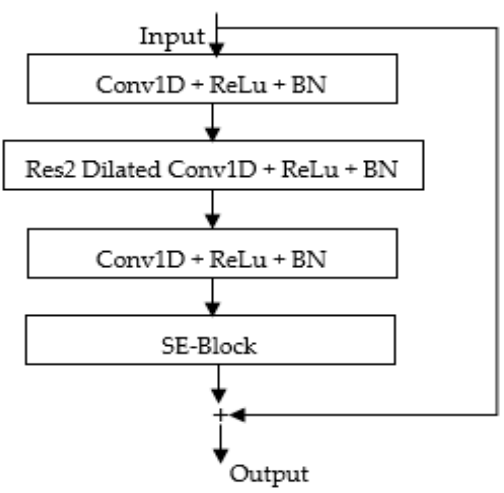
Figure 4. SE-Res2Block Architecture Figure 3. SE-Res2Block Architecture [9].